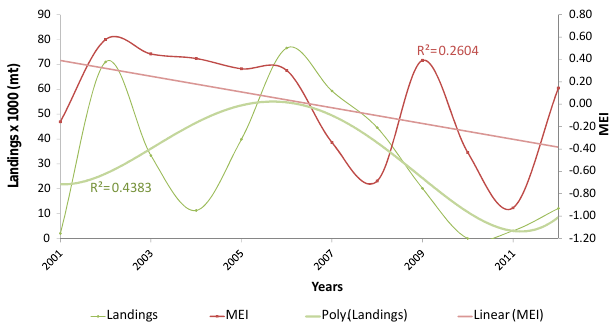
Figure 6. Landings (desembarque) of anchovy (2001–2009), asso- ciated with the MEI. Green solid curve ( n = 4) and the linear re- gression (straight